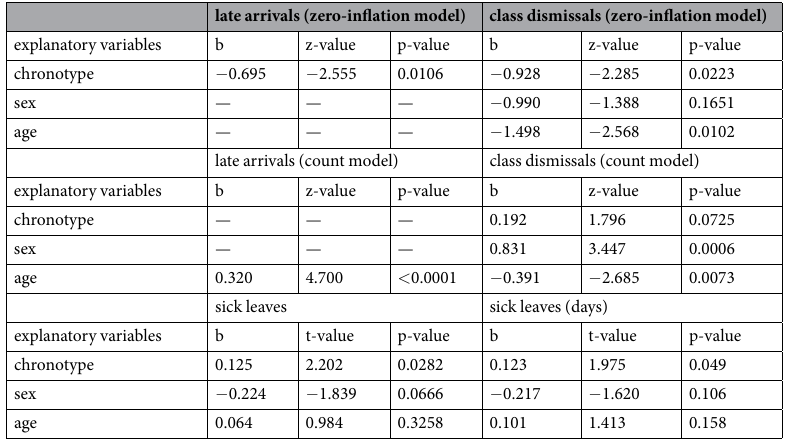
Table 3. Influence of chronotype, sex, and age on school attendance variables. The model estimates (b coefficients), the test statistic (z-test and t-test), and the p-values associated with each independent variable are reported. For late arrivals and class dismissals both the zero-inflation model and the count model statistics are indicated. If a variable was not included in the final selected model, this is indicated by horizontal dashes (—).